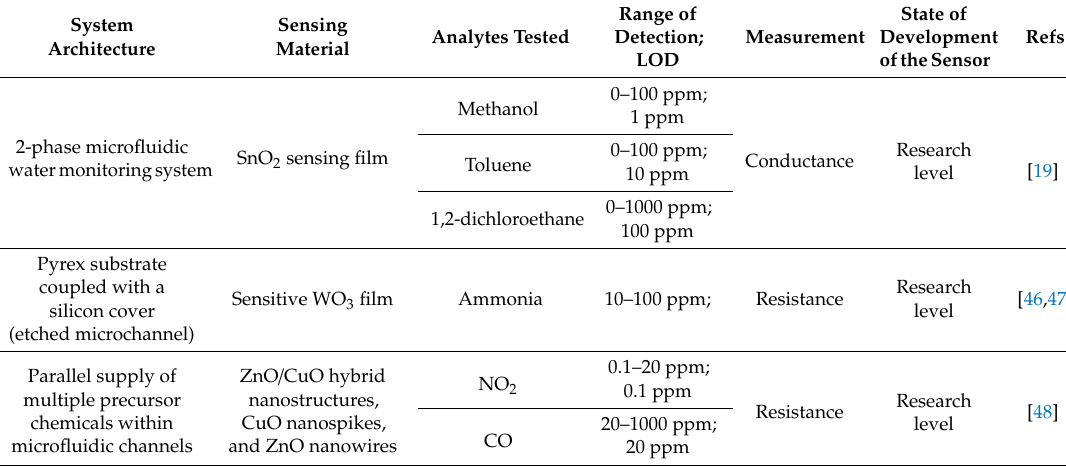
Table 2. Other VOC sensing systems that use MOS sensors (and no µ GC